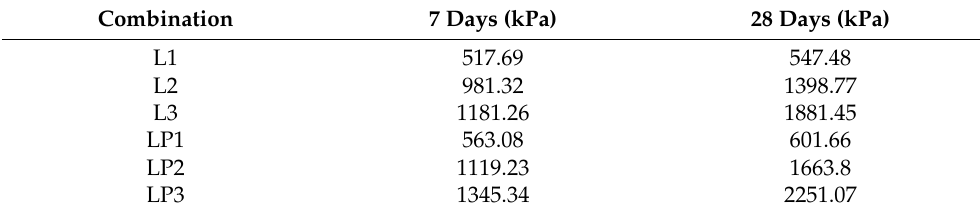
Table 4. Strength of Lime and Optimum PG Combinations.